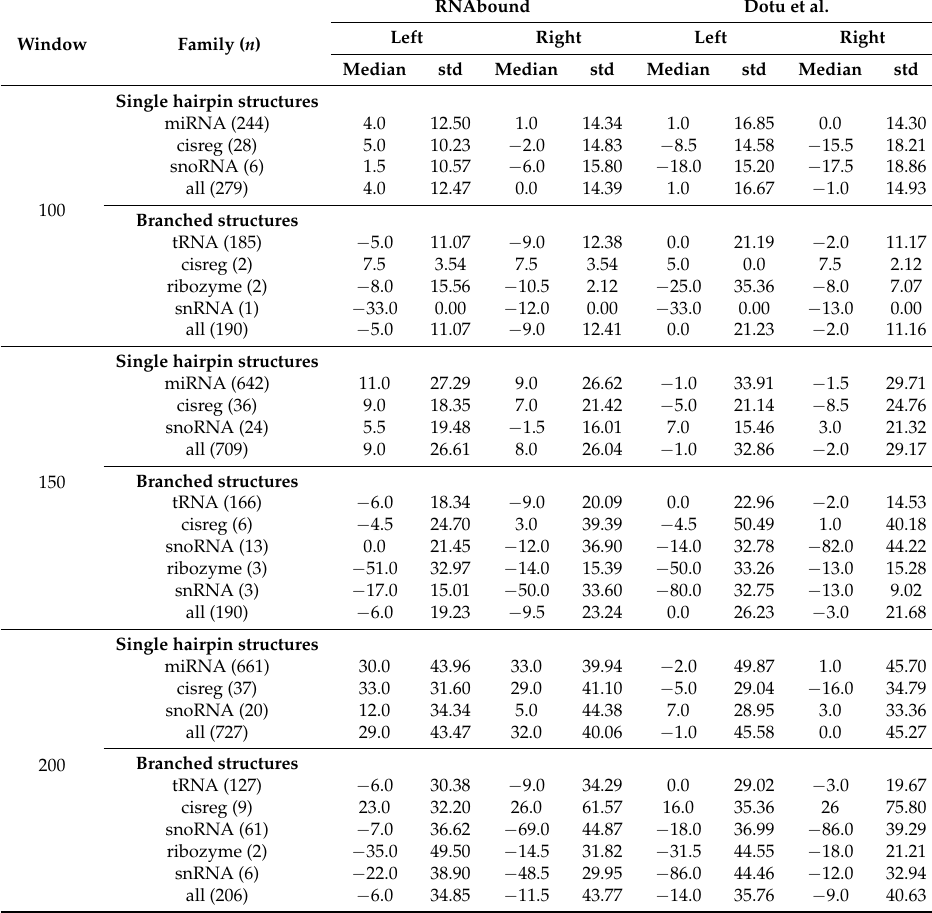
Table A1. Summary of boundary predictions from multiple sequence alignments with RNAbound and Dotu et al. The base pair probabilities were calculated with PETfold